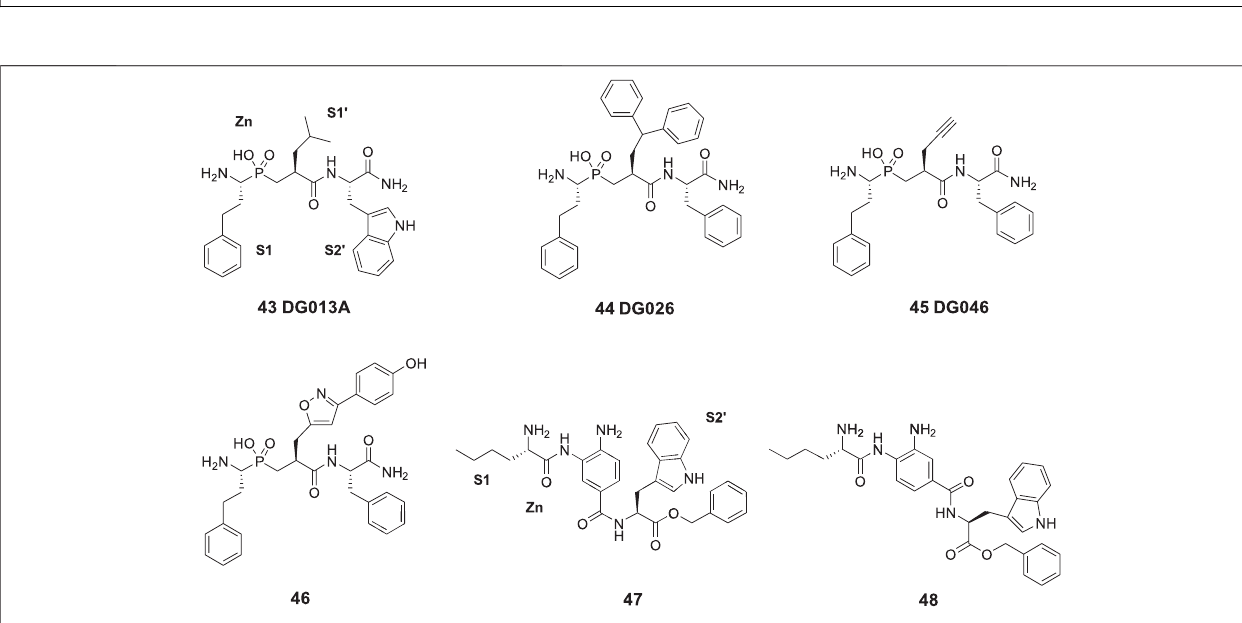
Figure 11 | The phosphinic pseudotripeptide 43 (DG013A) is a potent IRAP inhibitor but is not selective and is equally effective inhibiting both ERAP1 and ERAP2. Compound 44 (DG026) comprising a bulky P1 ʹ substituent is more IRAP selective than 43 . Compounds 45 (DG046) and 46 that are further modi fi ed in the P1 ʹ position are the most potent IRAP inhibitors in the series and approximately 10-fold selective vs. ERAP1 and ERAP2. The IRAP inhibitors 47 and 48 encompassing a 3,4- diaminobenzoic acid (DABA) scaffold are signi fi cantly less ef fi cient than 43 – 46 as IRAP inhibitors.